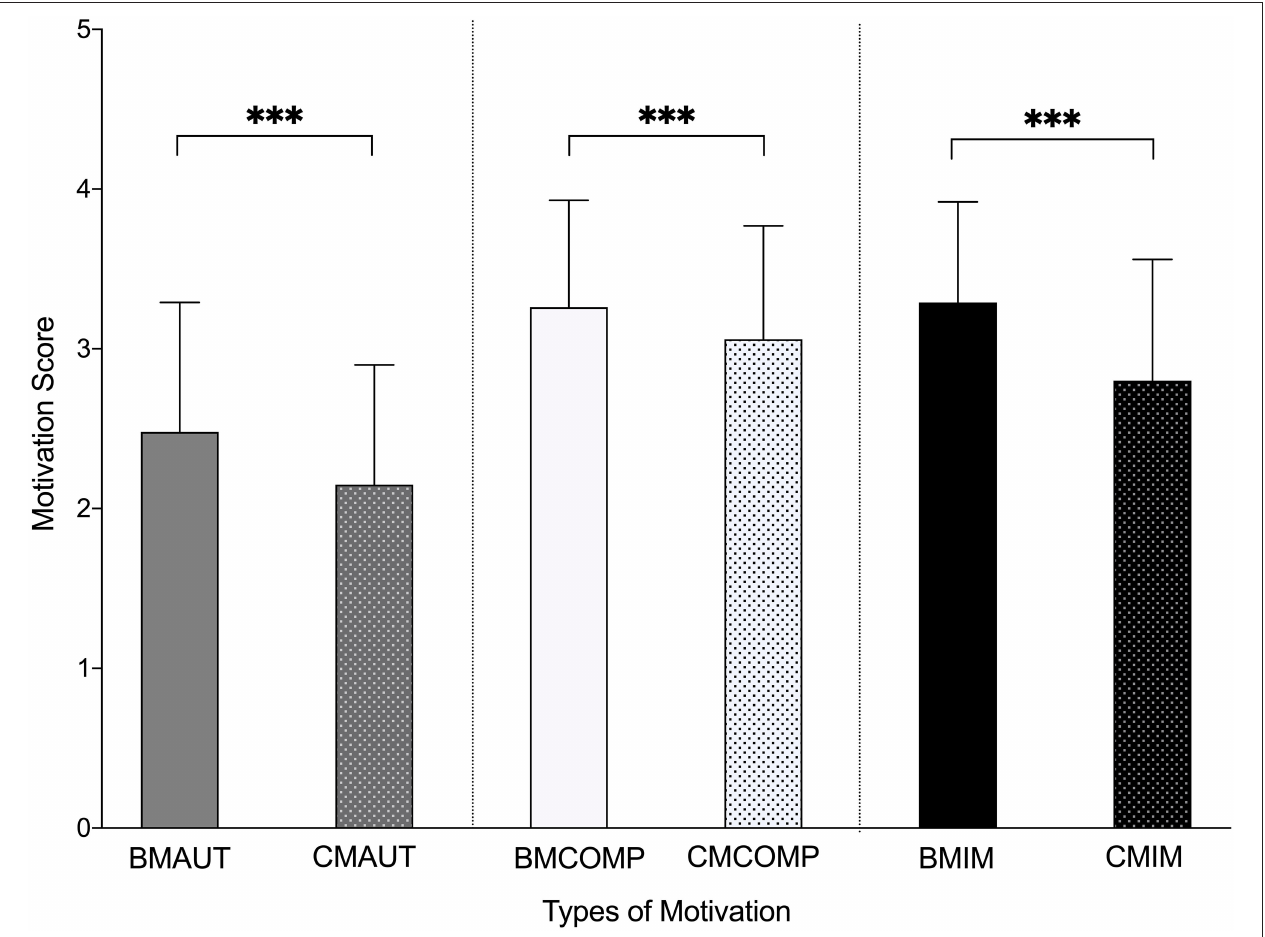
FIGURE 3 | Acutely Motivation (IMI) for the Intervention Group (BM). Acutely IMI measures for BM (Basketball sessions combined with mathematics). Motivation for sessions with basketball combined with mathematics (BM) were compared with motivation for classroom-based mathematics (CM) for the three different motivation types; autonomy (AUT), competencies (COMP), and intrinsic motivation (IM), *Indicates a significant difference between the two teaching methods (basketball combined with mathematics and classroom-based mathematics).